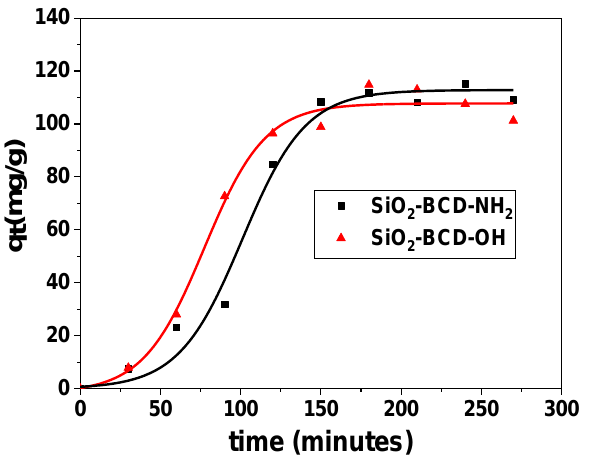
Figure 4. Effect of time on the adsorption process of BPA on SiO 2 -BCD-OH and SiO 2 -BCD-NH 2 . After 180 min of interaction at 25 ◦ C using a bisphenol A solution of 100 mg/L (Figure 4), an equilibrium state was reached for both materials with a q e value of 107 mg BPA/ g for SiO 2 -BCD-OH and 112 mg BPA/ g for SiO 2 -BCD-NH 2 . From Figure 4. it can be noted that the absorption process can be divided into two steps. First is a rapid adsorption stage, which can be explained by the high bisphenol A concentration in solution that diffuses and is adsorbed to the polymer particles’ surface. The second stage, after approximatively 150 min, represents an intermediary behavior when the adsorption rate decreases as the internal diffusion resistance increases, leading to the equilibrium